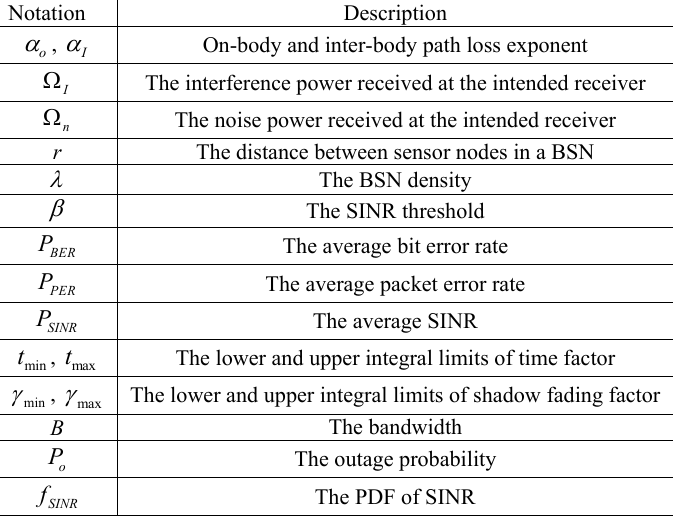
Table 1. The notations of the selected